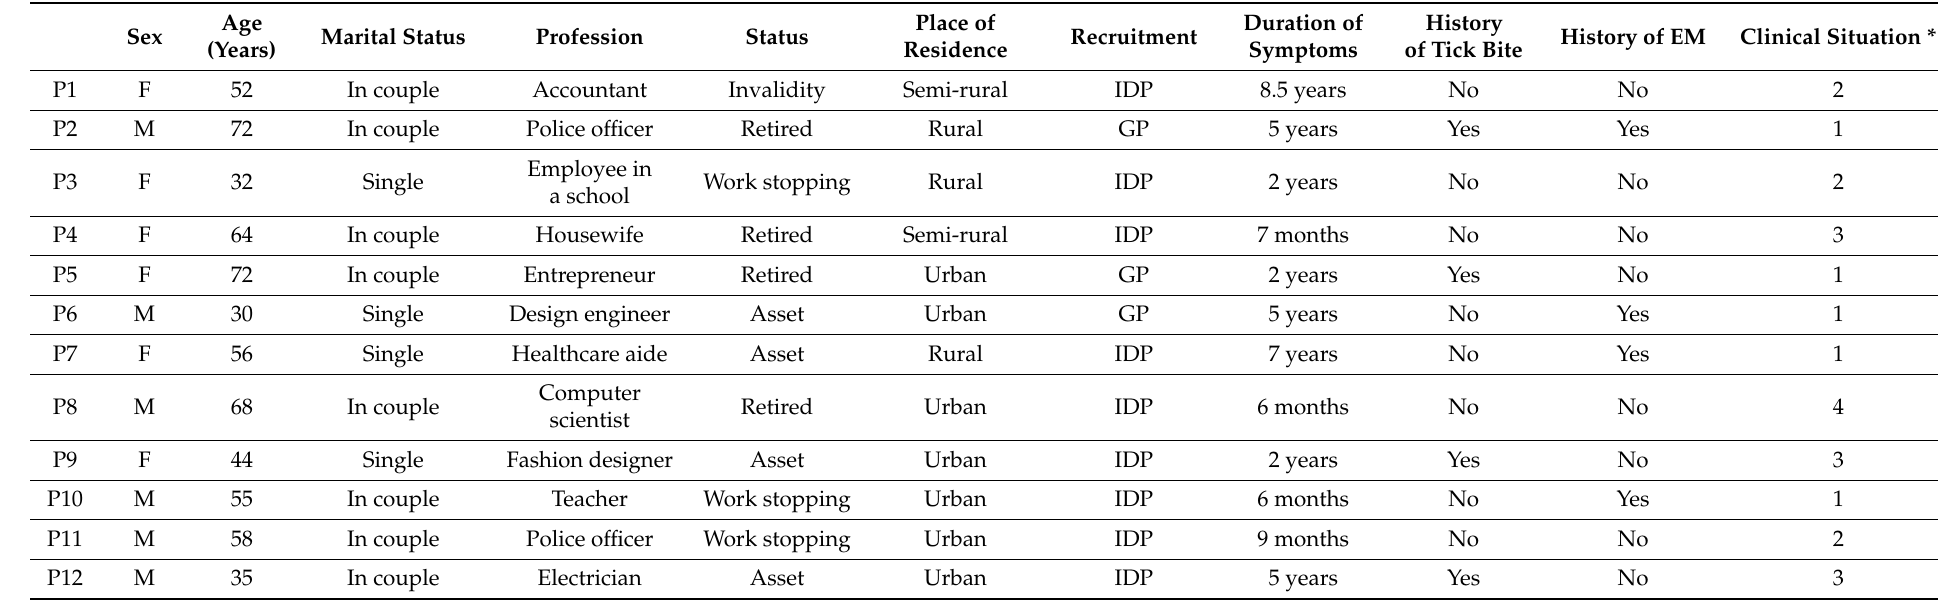
Table 1. Characteristics of the